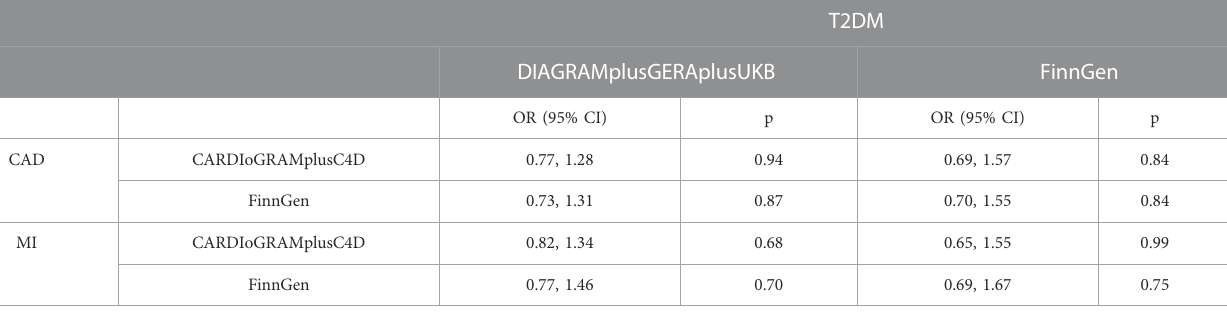
CAD, coronary artery disease; MI, myocardial infarction; T2DM, Type 2 diabetes; CARDIoGRAMplusC4D, Coronary Artery Disease Genome-Wide Replication and Meta-analysis plus the CoronaryArteryDiseaseGenetics;DIAGRAMplusGERAplusUKB,DIAbetesGeneticsReplicationandMeta-analysis(DIAGRAM),GeneticEpidemiologyResearchonAging(GERA)andthe UK, Biobank (UKB).